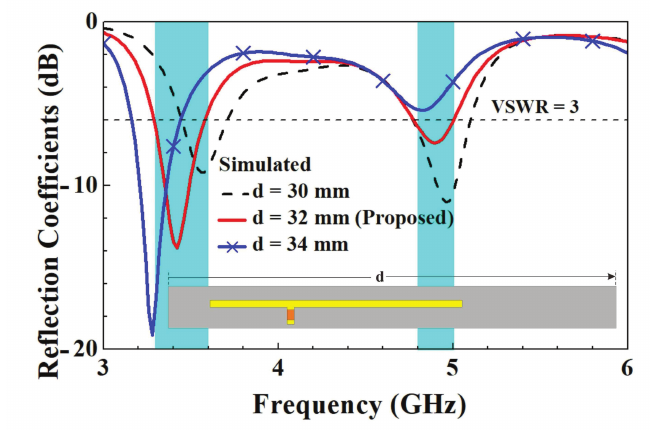
Figure 16. Comparison of simulated reflection coefficients with changes in parameter d